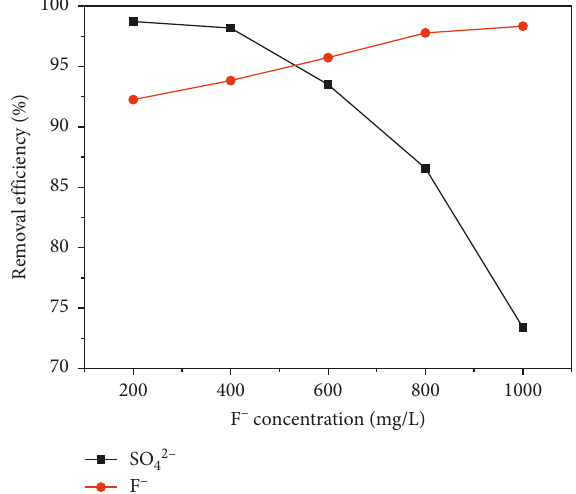
Figure 9: The effect of F S) 4 :1:1, v (cid:27)